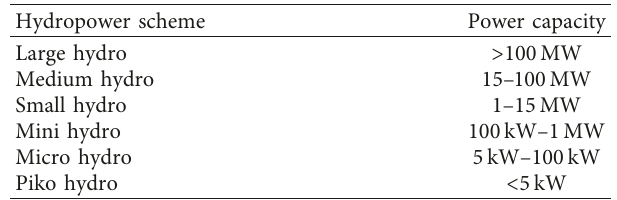
Figure 1: Solar and hydro hybrid power plant configurations. Table 1: Classification of hydropower plants based on power capacity